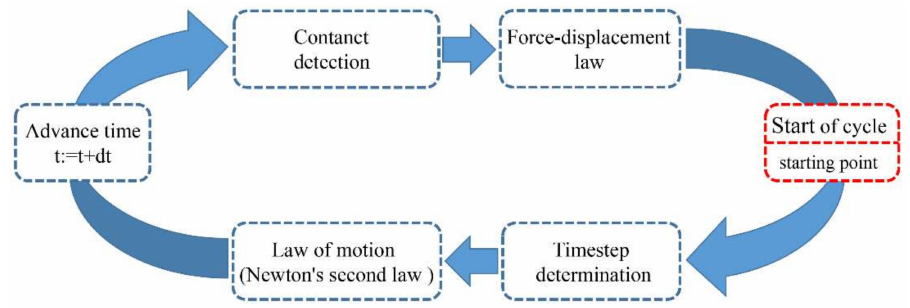
Figure 5. Schematic of using PFC 2D for a loop calculation about Newton’s second law and force-displacement relationship.